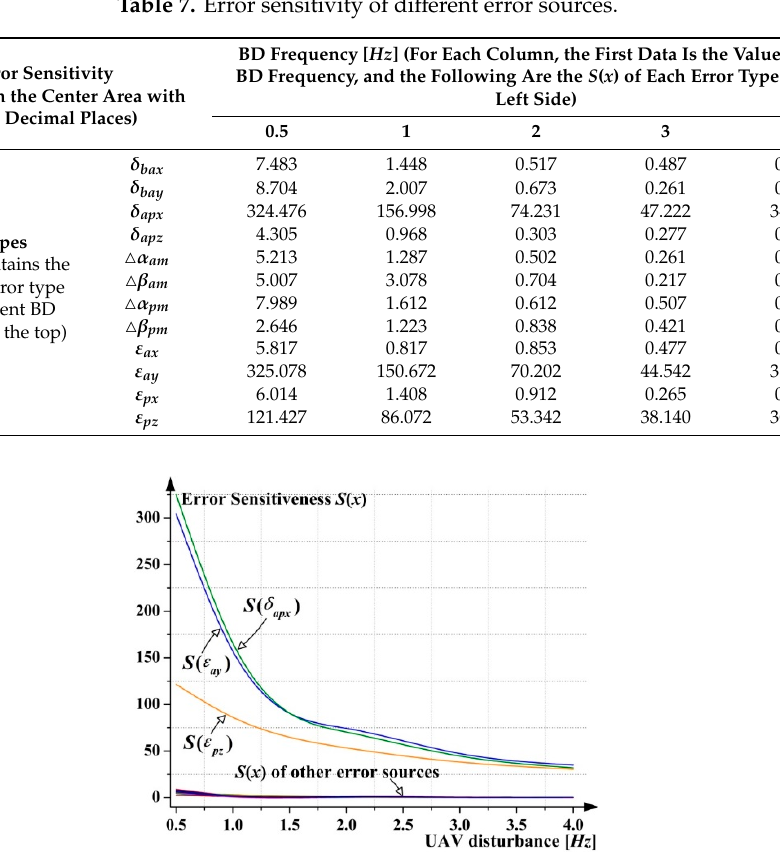
Figure 16. Error sensitivity of different error sources.